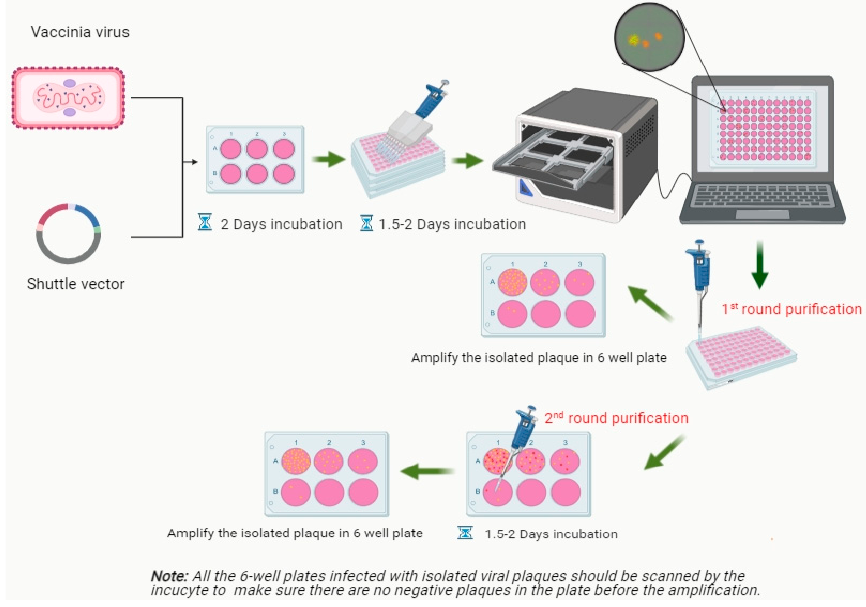
Figure 1. Workflow of construction and isolation of rVACV expressing fluorescent proteins.